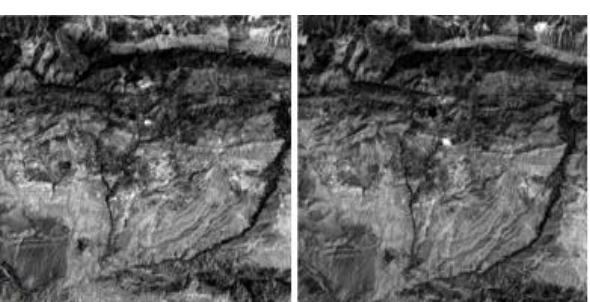
Figure 2: Reduced resolution stereo images of the test area. Nearly 402 points are manually measured. These points cover the entire ground coverage of the scene and are selected in such a way that they form salient feature points compared to their surroundings.